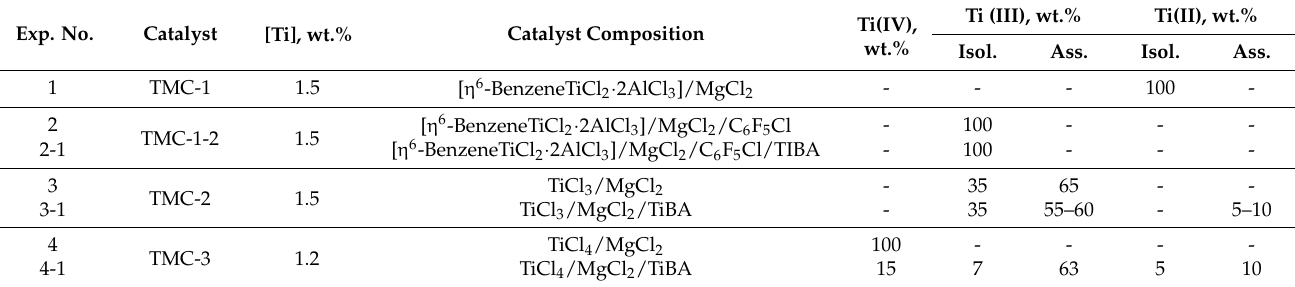
Table 1. Content of titanium in different oxidation states and different environments in TMC synthe- sized using titanium compounds of different